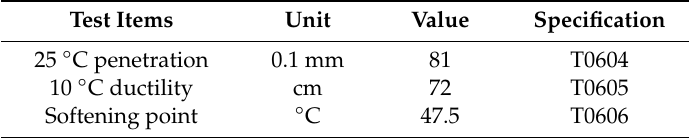
Table 1. Physical Properties of Asphalt